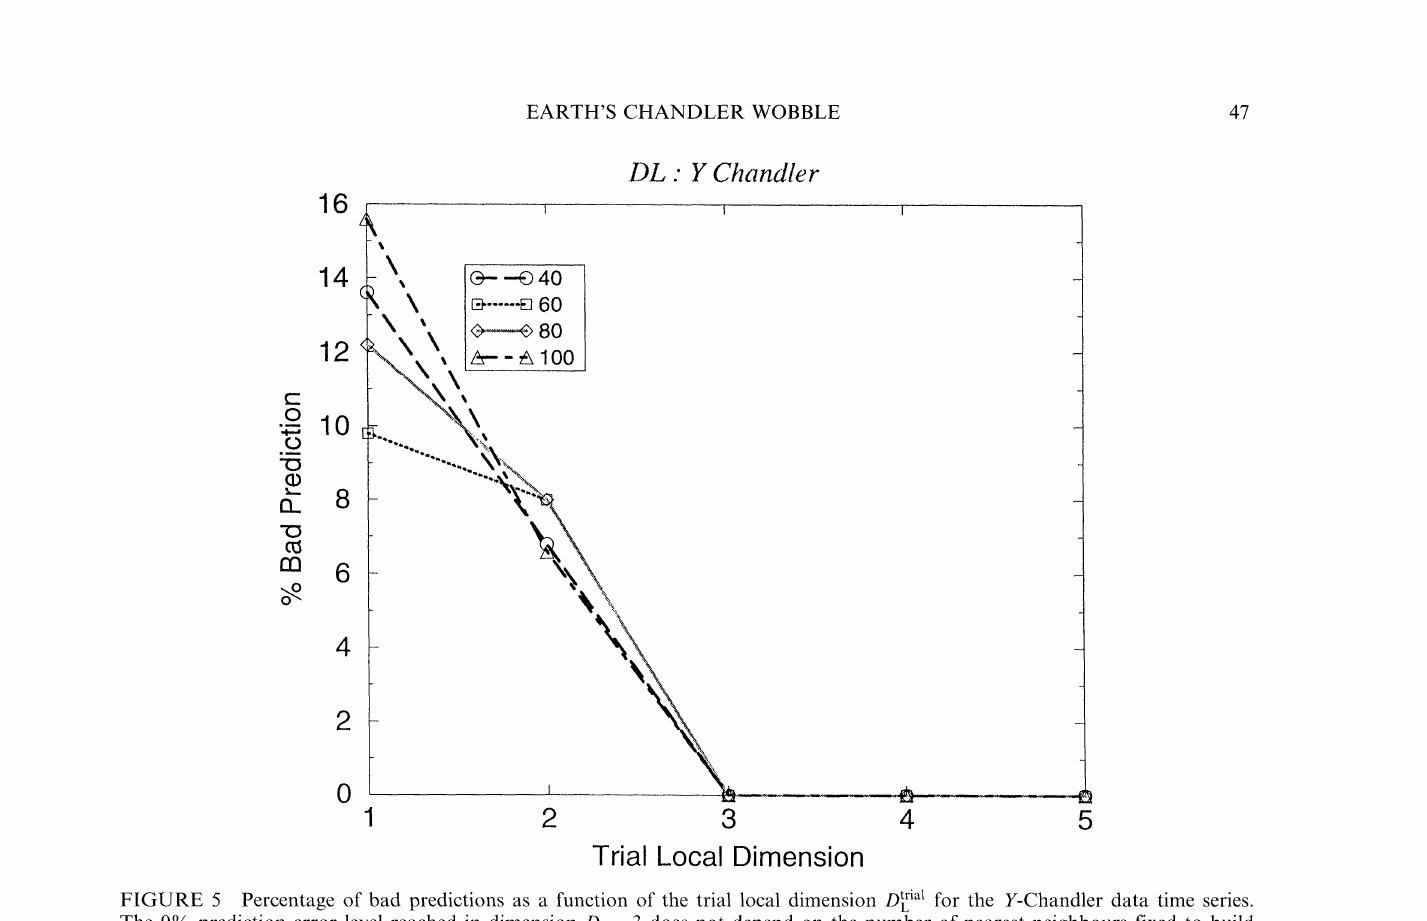
FIGURE 5 Percentage of bad predictions as a function of the trial local dimension D ial for the Y-Chandler data time series. The 0% prediction error level reached in dimension DL 3 does not depend on the number of nearest neighbours fixed to build the local covariance matrices (see text) and indicated in the